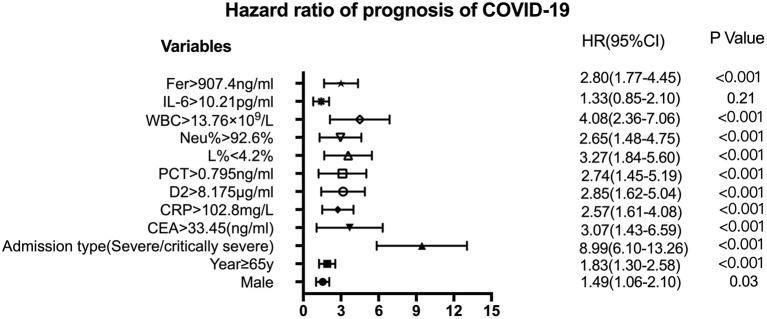
Forest plots of CEA, CRP, D2, Fer, IL-6, L%, Neu%, PCT, and WBC levels with other factors to assess the HR of the prognosis of COVID-19. The variables shown on the left of the axis, while the P-values are shown to the right of the HR. CI, confidence interval; HR hazard ratio; COVID-19, Coronavirus disease 2019; CRP, C-reactive protein; PCT, procalcitonin; Fer, ferritin; WBC, white blood cell; D2, D-dimer; Neu%, neutrophils percentage; L%, lymphocyte percentage; CEA, Carcinoembryonic antigen; IL-6, interleukin 6.